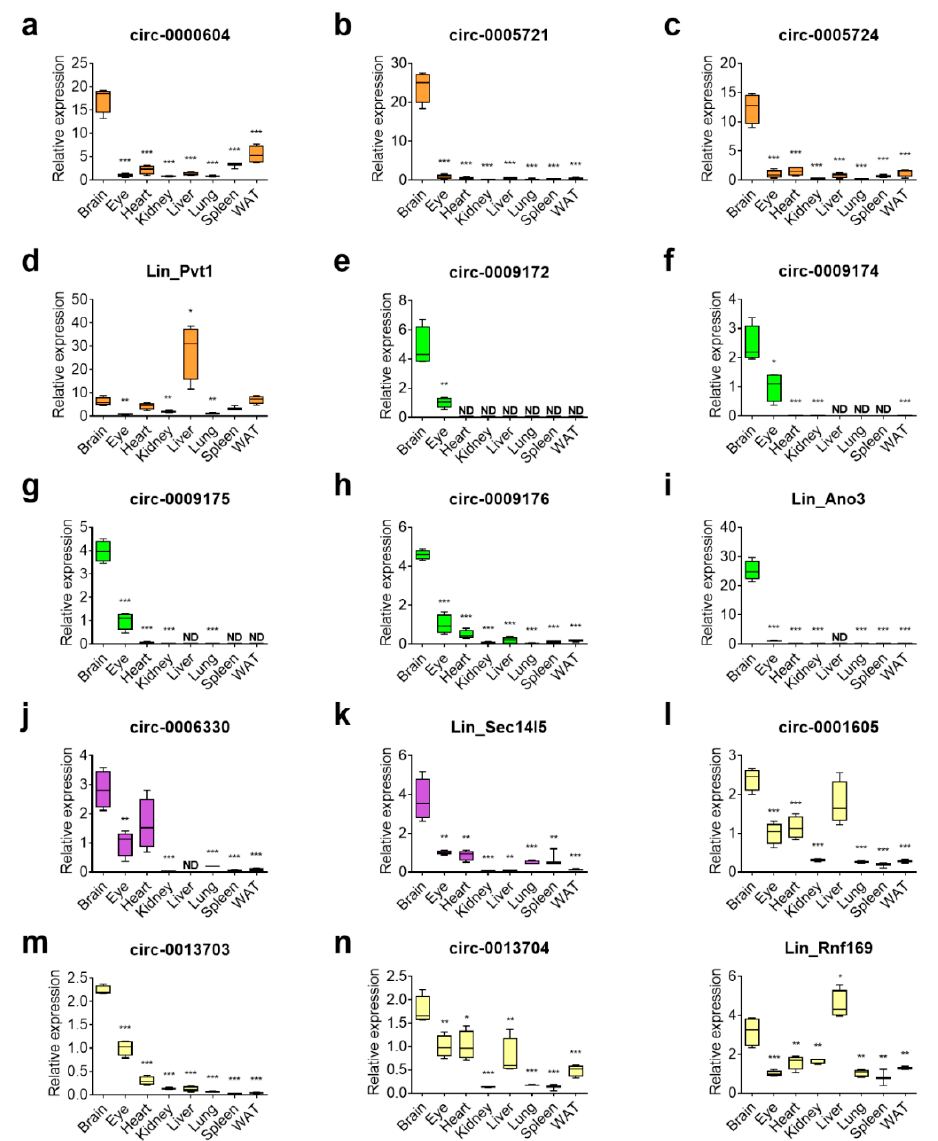
Figure 4. Profiling of circRNA expression across mouse tissues reveals enrichment in the brain. RT-qPCR analysis was performed to investigate the tissue distribution of ( a – d ) Pvt1 ; ( e – i ) Ano3 ; ( j,k ) Sec14l5; and, ( l – o ) Rnf169 . The expression levels for each transcript variant are given as box plots for eight indicated tissues and normalized against expression in the eye (set at 1.0). Centerlines show the median; boxes represent the range between first and third quartiles and whiskers represent the highest and lowest values of four biological replicates ( n = 4). Note that in some tissues the expression levels were very low compared to the brain, but still above background. For comparisons between the brain and other tissues, a one-way ANOVA with Dunnett’s correction for multiple comparisons was used; * p < 0.05; ** p < 0.01; *** p < 0.001. WAT: white adipose tissue; ND: not detected.